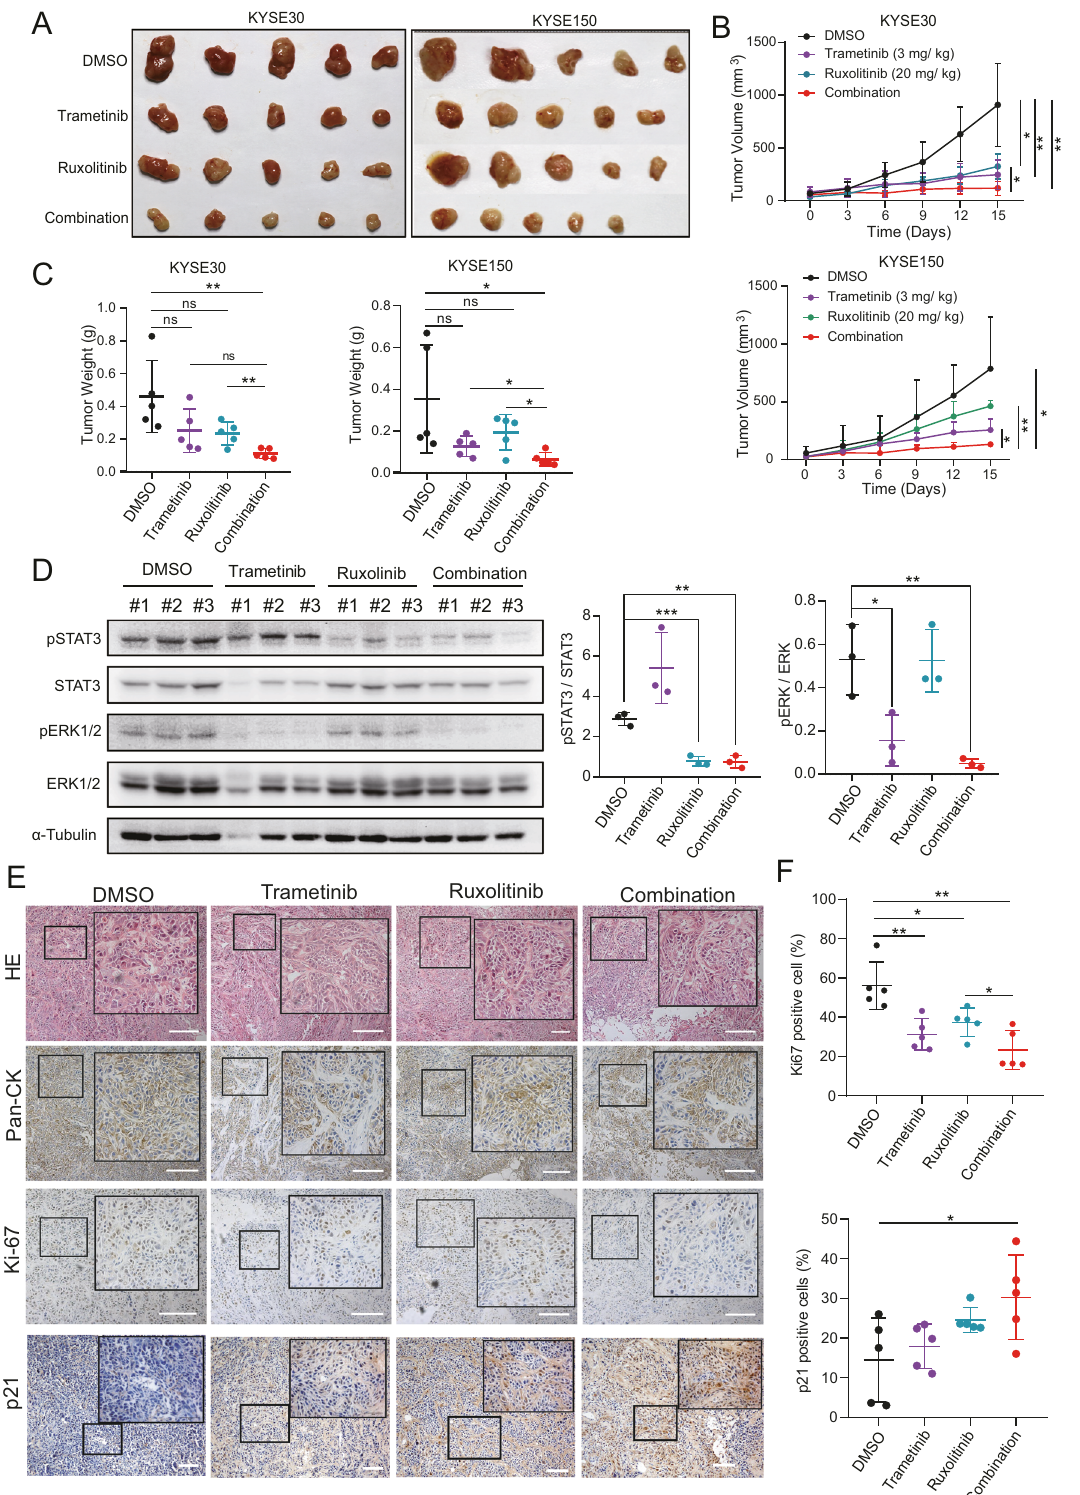
Fig. 7 Suppression of MEK using a combination of trametinib with ruxolitinib leads to tumor growth regression in vivo. A – C Nude mice bearing KYSE30 and KYSE150 tumors were treated with the indicated inhibitors for 15 days. Tumor size ( A ), tumor volumes ( B ), and tumor mass at the endpoint ( C ) are shown. D Western blotting results show the expression of pSTAT3 and pERK1/2 in xenograft tumors exposed to the indicated treatment. Densitometry analyses of pSTAT3 and pERK1/2 expression normalized to STAT3 and ERK1/2 expression, respectively. Error bars represent the mean ± SD. * P < 0.05, ** P < 0.01, *** P < 0.001. E HE staining and IHC of xenograft tumors. F The percentage of Ki67- and p21-positive cells were determined using IHC (right). Scale bar, 100 μ m. Error bars represent the mean ± SD. * P < 0.05, ** P < 0.01, *** P <